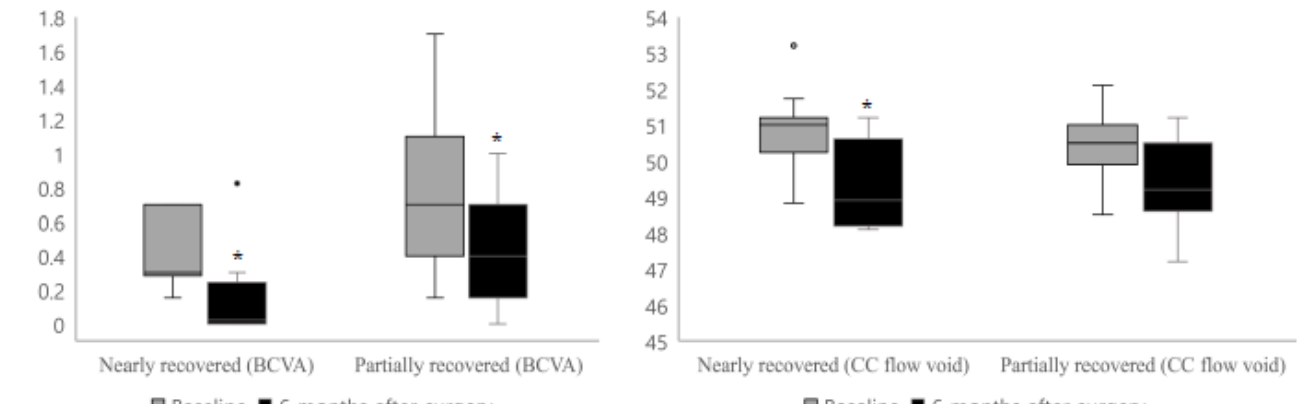
Figure 5. Box-plot graph of BCVA (logMAR) and CC flow void. Preoperative and six months postoperative data of the nearly recovered and partially recovered groups was compared. Compare to preoperative values, BCVA significantly improved six months postoperatively ( p = 0.005). In the nearly recovered group, the center area of the CC flow void decreased significantly after six months ( p = 0.018). However, the partially recovered group showed no significant difference in CC flow void six months postoperatively compared to preoperative values ( p =0.249). * P -value < 0.05.